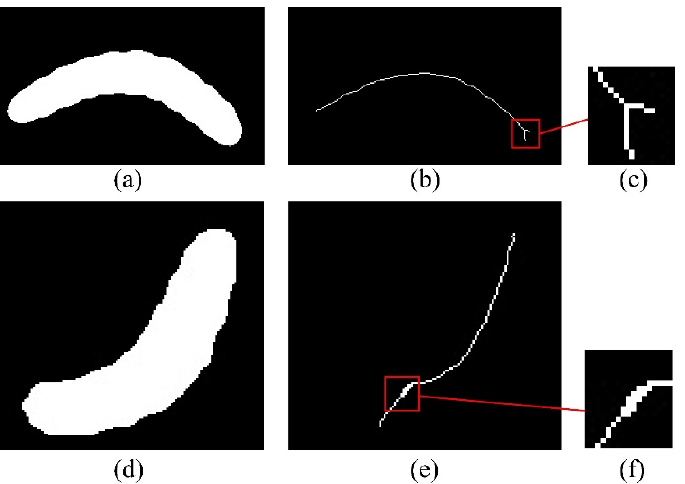
Figure 7. Visualization of the ZS thinning algorithm. ( a , d ) The segmentation mask of the Mask R-CNN. ( b , e ) The pest skeleton images. ( c , f ) The local details of the pest skeleton.